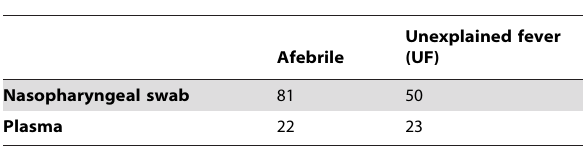
Nasopharyngeal swab 81 50